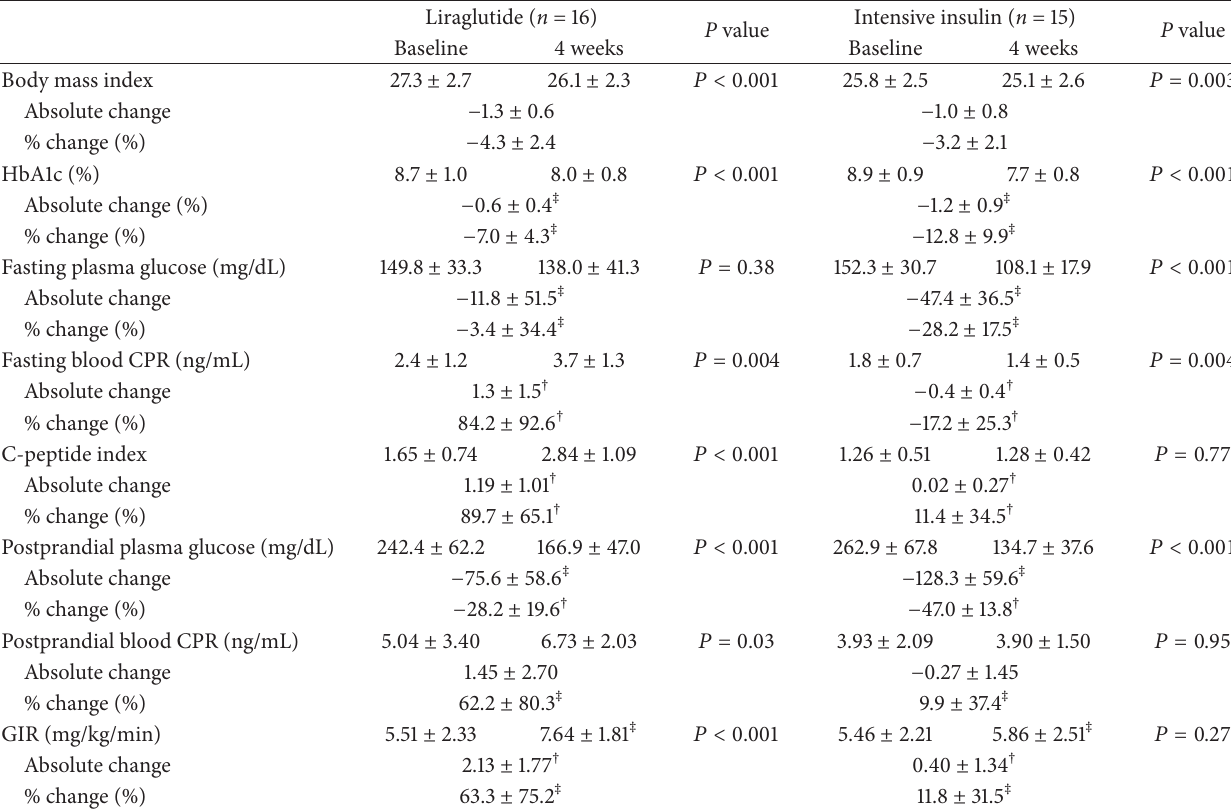
Table 2: Changes in body weight and glucose metabolic parameters before and after